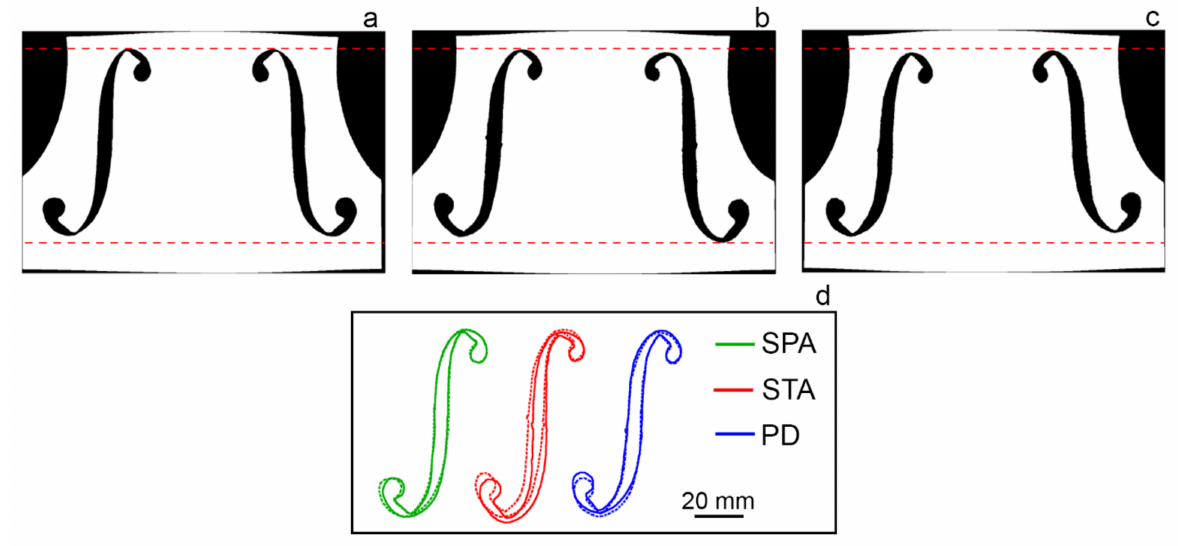
Figure 7. F-hole shapes of the “Spagnoletti” ( a ), the “Stauffer” ( b ), and the “Principe Doria” ( c ) and their position on the soundboard between the waists. Red dotted lines mark the maximum upper and lower position of the f-holes. Outlines of the f-holes ( d ) of the “Spagnoletti” (SPA), the “Stauffer” (STA), and the “Principe Doria”